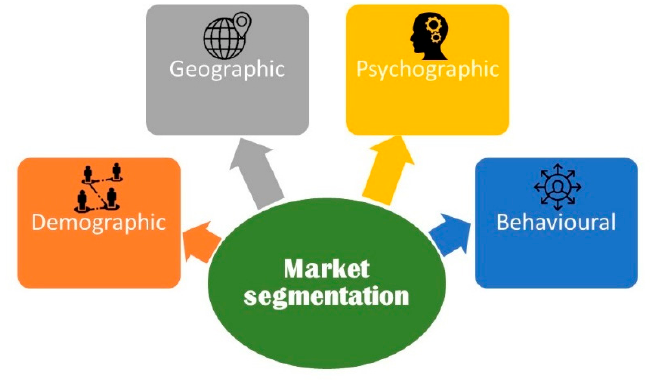
Figure 3. Marketing segmentation (author’s own work).